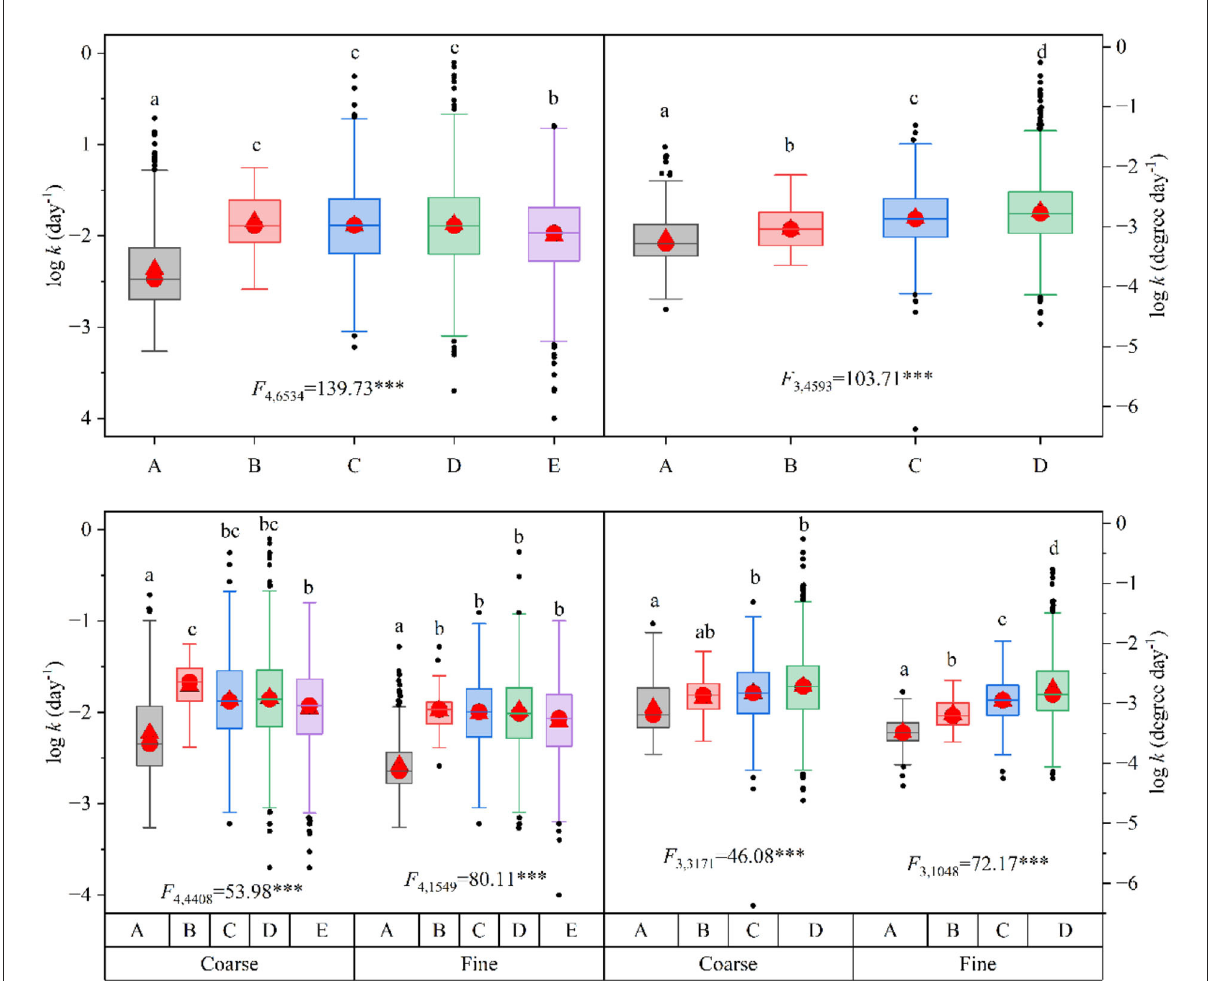
FIGURE2 Comparisons of leaf-litter breakdown rates (per day, left; per degree day, right) in this study (A) with other global-scale studies [B, Boyero et al., 2016; C, Follstad Shah et al., 2017; D, LeRoy et al., 2020; E, Zhang et al., 2019]. Box plots summarize the distribution of all values. Box plots indicate the interquartile ranges (box part), 25th and 75th percentiles (lower and upper error bars), median values (red circles in the box), mean values (red triangles in the box), and outliers (black dots). Lowercase letters above each box indicate a significant difference among studies after one-way ANOVA and post-hoc Tukey’s t -test (parameters with the same letter are not significantly different between studies, P > 0.05) was used. *** P < 0.001.